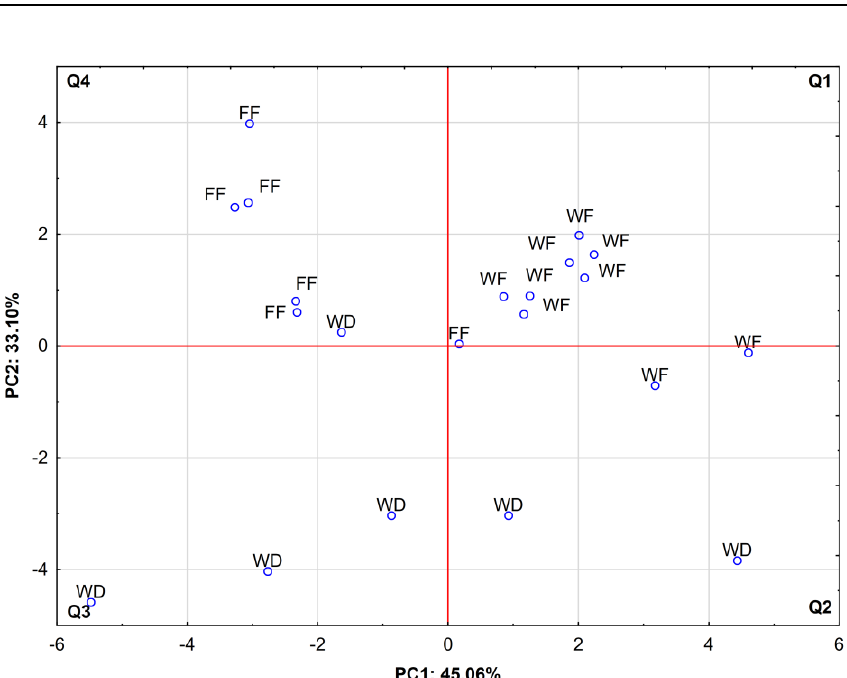
Figure 2. Projection of cases, depending on red deer group, in a two-factor plane (PC1 × PC2); FF — farm fawns; WF — wild fawns; WD — wild does.